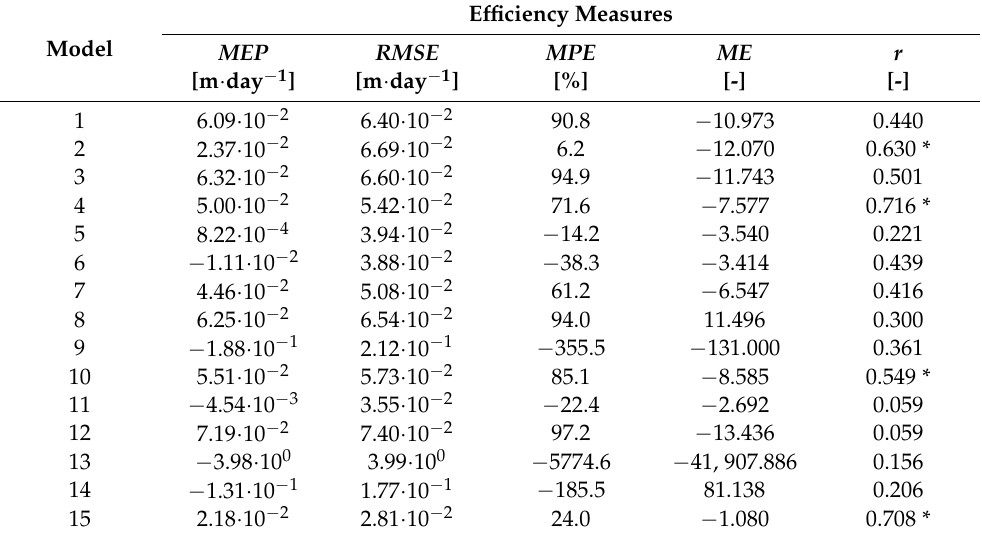
Table 7. Model efficiency measures.